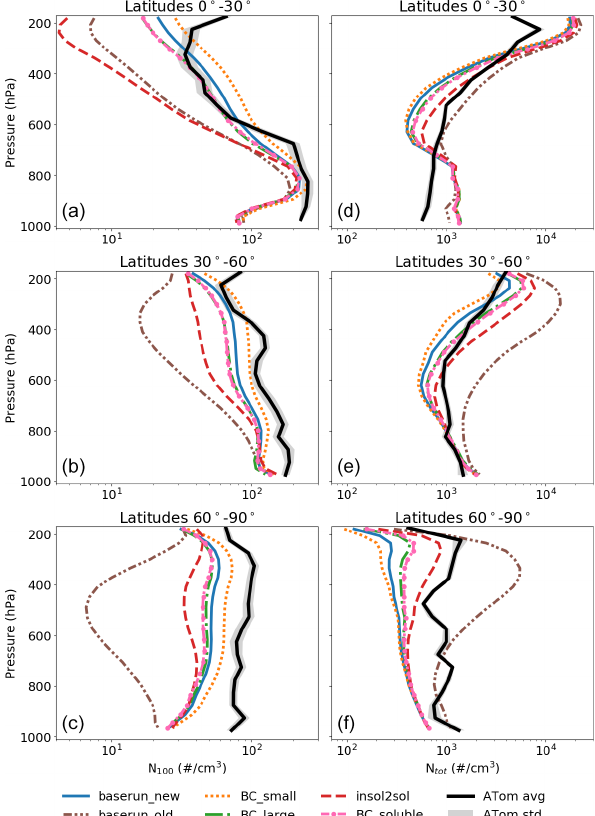
Figure 6. Mean vertical profiles of the N 100 (a–c) and N tot (d– f) concentrations, modeled with different studies, compared to the mean of ATom aircraft measurements in different latitude